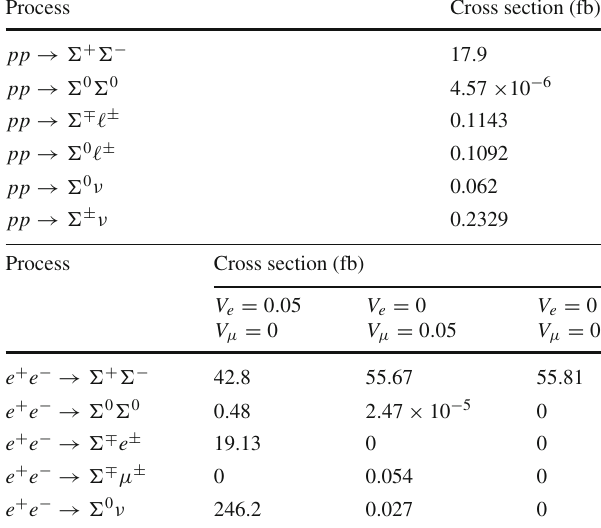
Table 2 Cross sections for different production processes at 14 TeV LHC and 2 TeV e + e − colliders. In the case of LHC, (cid:4) = e , μ cor- responding to the two combinations of ( V e = 0 . 05 , V μ = 0 ) or ( V μ = 0 . 05 , V = 0 ) , respectively. The two above mixing scenar- e ios give identical results in the case of LHC processes with ν in the final state, whereas the pair production processes are independent of the mixing. The mixing in the case of e + e − collider is as explicitly mentioned. The mass of the fermion is taken to be M (cid:2) = 500 GeV